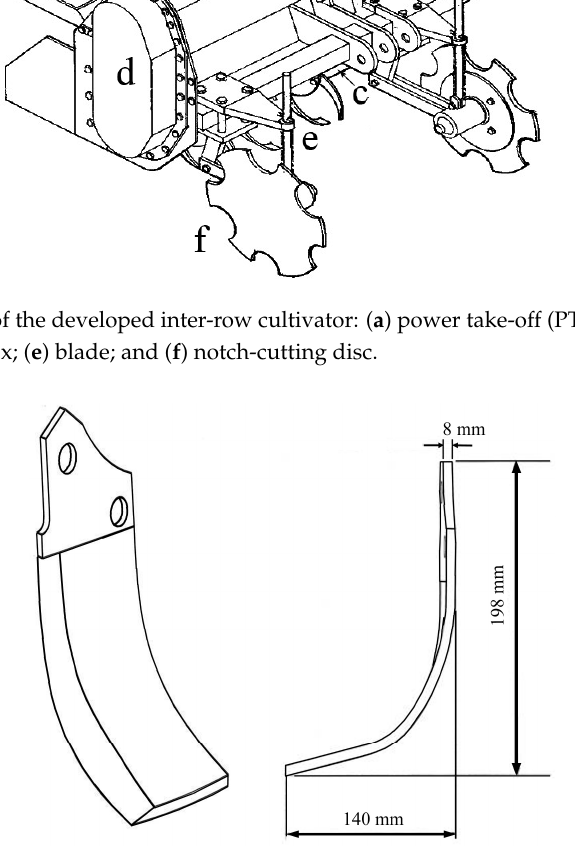
Figure 4. European C-shaped blade.